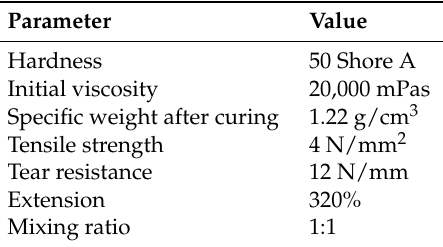
Table 2. Properties of ZA 50 LT